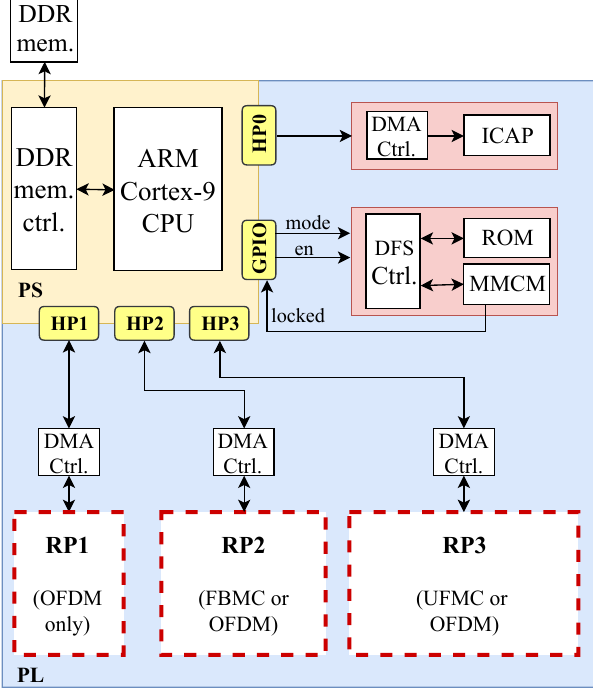
Figure 7. Top-level architecture. HPx: High Performance ports, GPIO: General Purpose I/O, RP, Reconfigurable